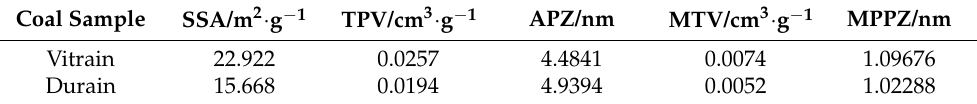
Table 4. Results of liquid nitrogen adsorption experiments on vitrain and durain samples. Coal Sample